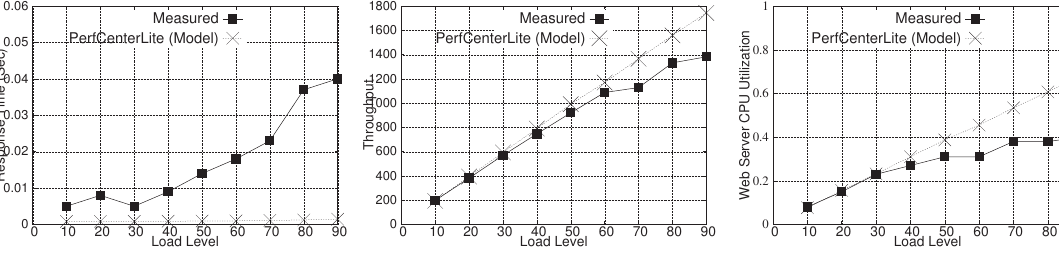
Figure 6: Measured vs Modeled Performance Metrics Validation for Software Bottle Neck (Experiment 4)